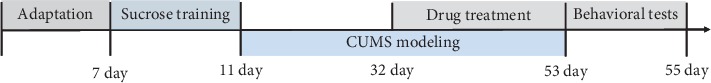
Experimental design. Timeline of animal experiments, chronic unpredictable mild stress (CUMS) procedure, drugs administering, and behavioral tests including sucrose preference test (SPT) and forced swim test (FST).